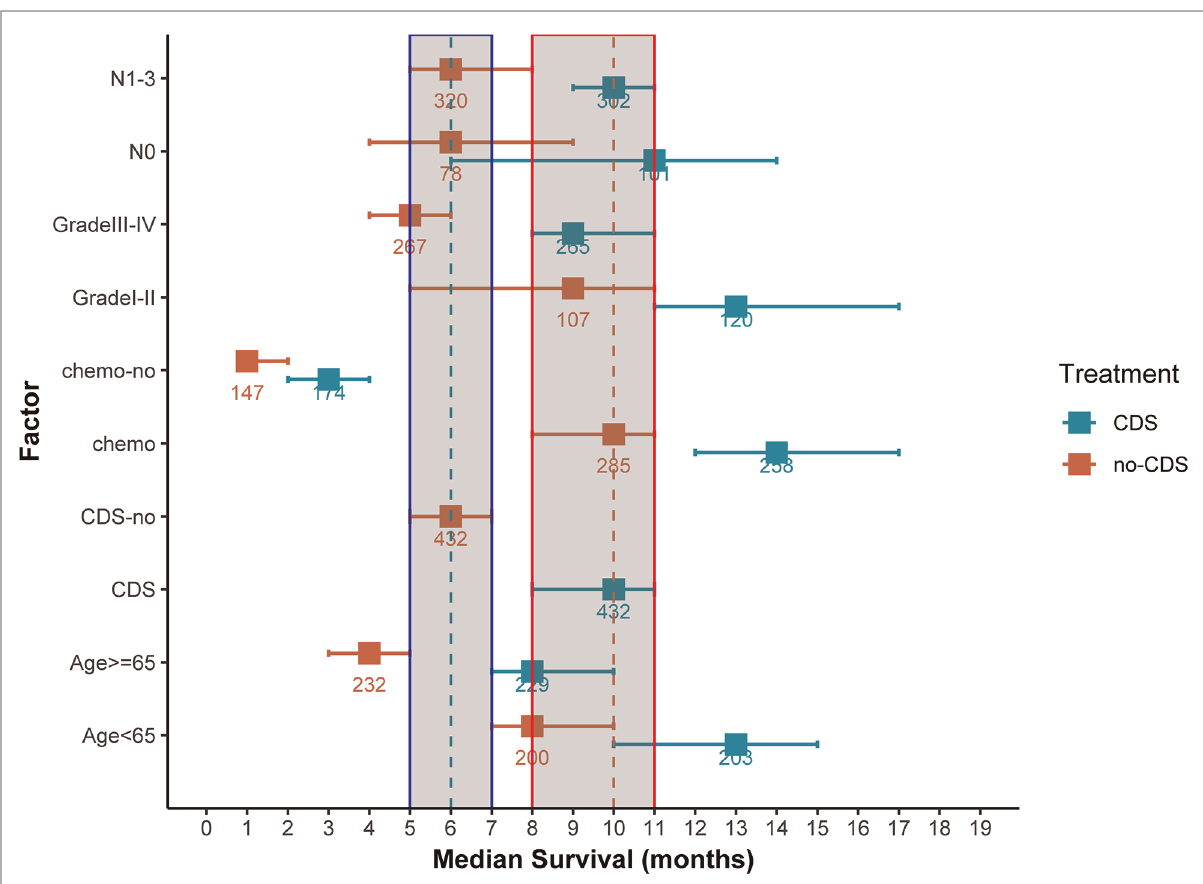
FIGURE 2 Median overall survival (months)±95% con fi dence interval for patients in the CDS and No-CDS groups. The dashed and shaded areas cover the median and con fi dence intervals for the total sample. Numbers are sample sizes. For ease of reading and understanding, certain factor levels have been removed and results are given for the total sample and for meaningful prognostic factors. CDS: cancer-guided surgery, Grade: tumor differentiation grade, N: tumor stage N, chemo: